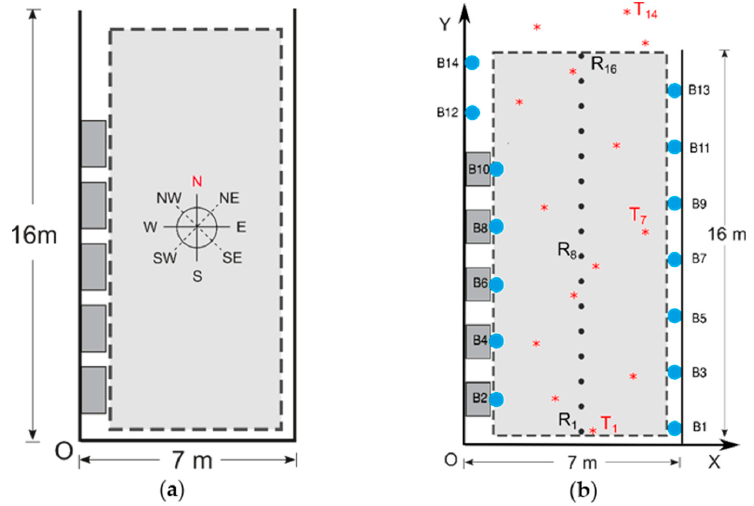
Figure 7. Schematic view of the first scenario: ( a ) Dimensions and orientations, ( b ) beacons, RP and TP positions.